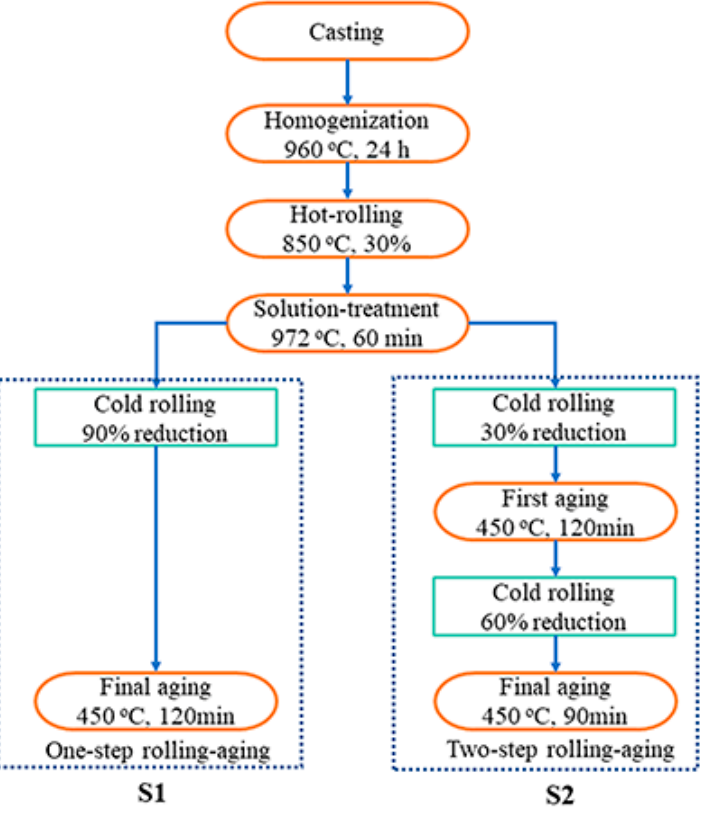
Figure 1. The process flow chart in this study.